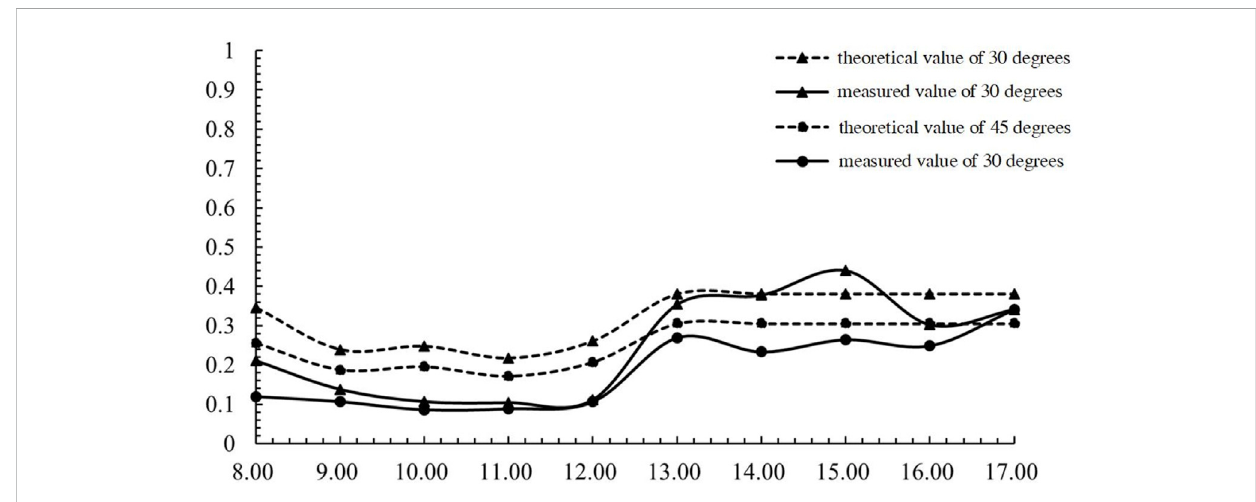
FIGURE 8 Comparison of theoretical and measured transmittance values of blinds at different times.